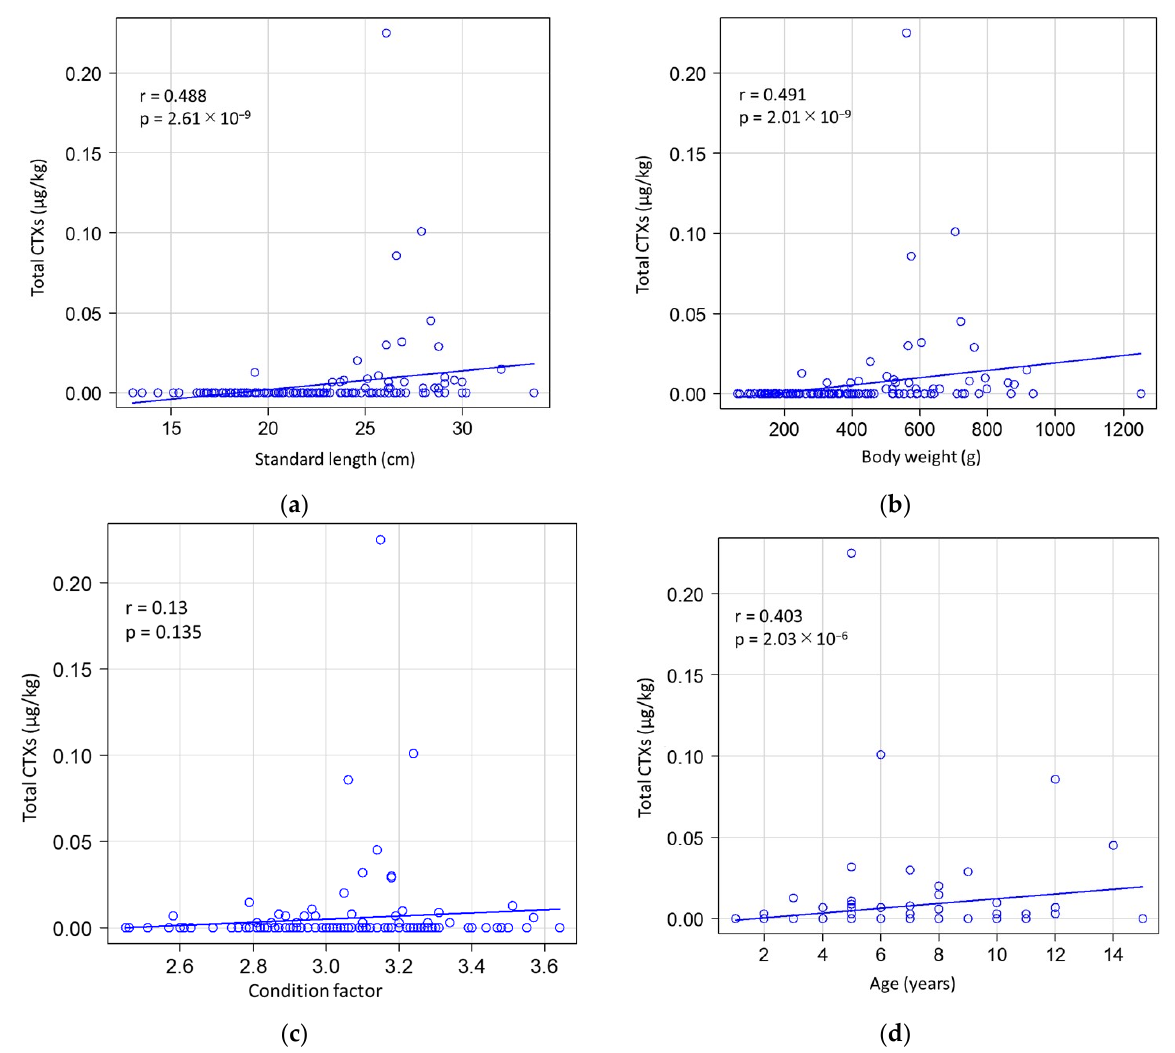
Figure 6. Relationship between biological data and total CTX levels in the flesh of V. albimarginata captured from Okinawa, Japan. ( a ) Standard length, ( b ) body weight, ( c ) age, and ( d ) condition factor.